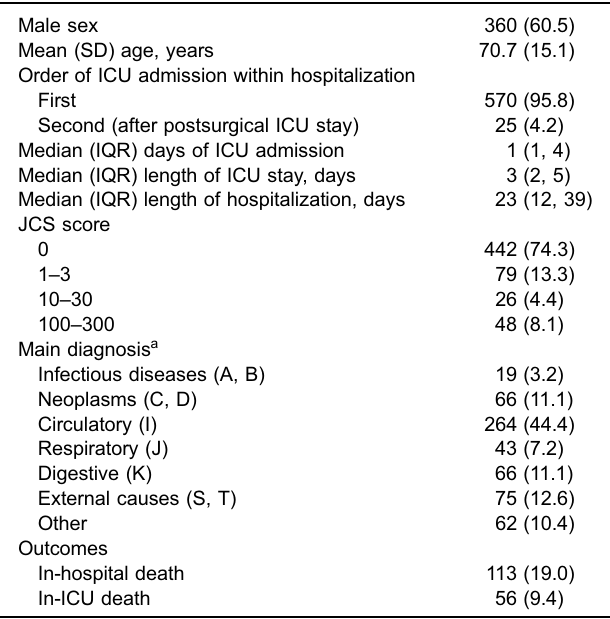
Table 1. Patient demographics ( n = 595)